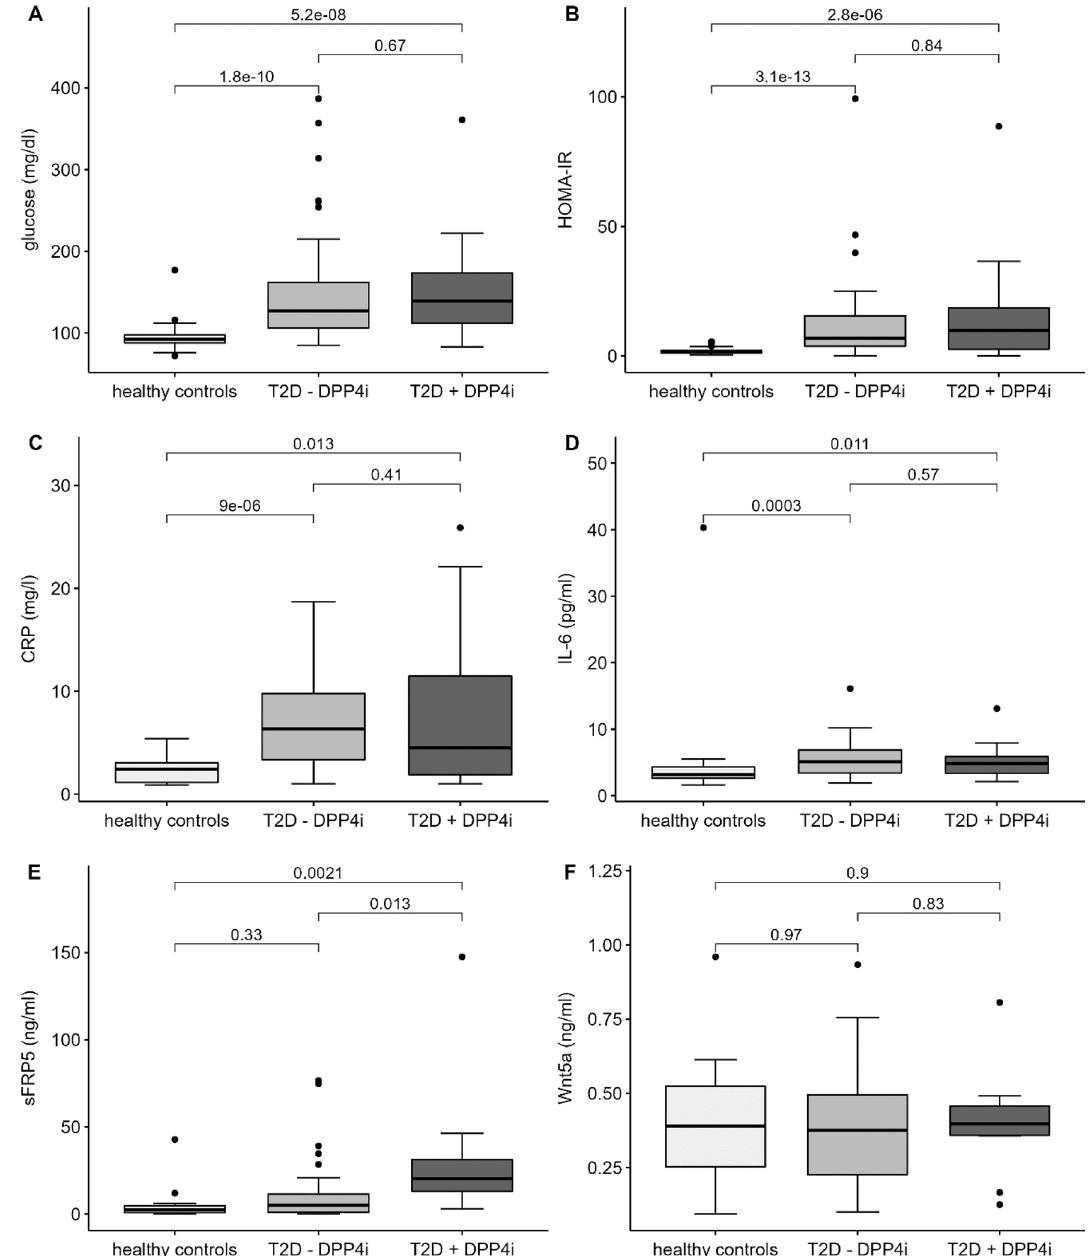
Figure 1. Differences of clinical parameters between FoCus subjects with T2D taking DPP4i (T2D + DPP4i), without DPP4i treatment (T2D-DPP4i) and healthy controls were investigated: Glucose ( A ), HOMA-IR ( B ), CRP ( C ), IL-6 ( D ) were significantly higher in diabetic subjects with and without DPP4i treatment compared to healthy controls, no differences between subjects with and without DPP4i treatment. ( E) Diabetic subjects with DPP4i treatment showed significant higher levels of sFRP5 compared to diabetic subjects without DPP4i treatment and healthy controls. ( F) Wnt5a levels showed no differences between groups. Wilcoxon test; statistical significance p <